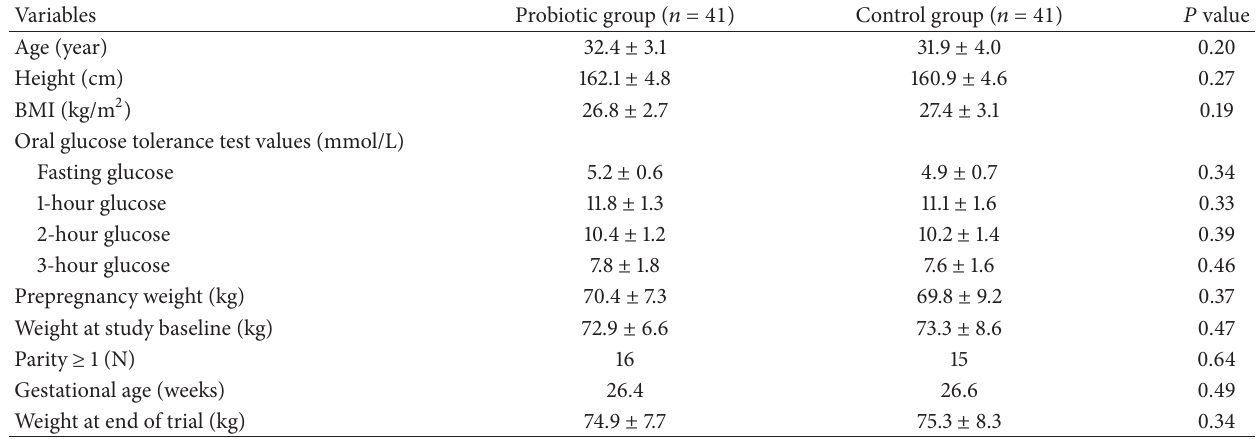
Table 1: Baseline characteristics of the intention-to-treat